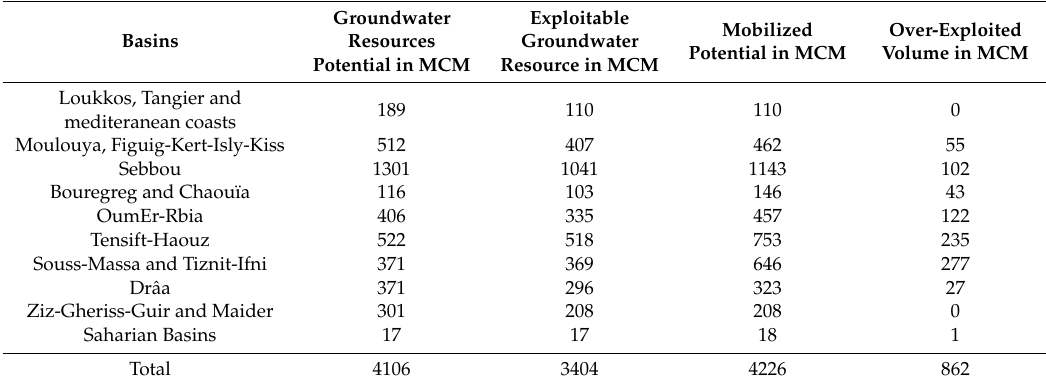
Table 1. Distribution of mobilized groundwater resource potential in di ff erent Moroccan basins (updated from [21]). See Figure 2a for basin locations.